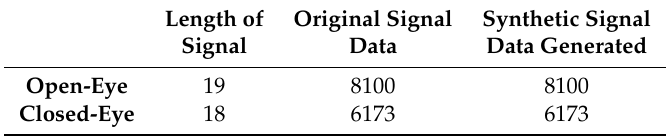
Table 6. Details of Synthetic Electroencephalogram (EEG) Signals Generated.